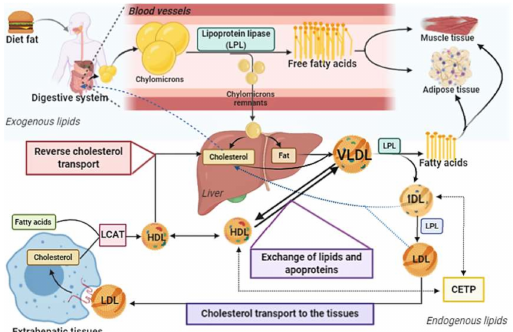
Figure 1. First, dietary fat is emulsified by bile salts, being degraded by lipases. Fatty acids are absorbed through the intestinal mucosa, being converted into triacylglycerol. Then there is the joint incorporation of cholesterol, triglycerides and apolipoproteins (Apo-CII and Apo-B48), forming the chylomicrons. Dietary fat is transported in the blood and lymph vessels by the chylomicrons. Apo-CII on the surface of chylomicron activates the enzyme lipoprotein lipase (LPL), which releases fatty acids and glycerol to tissues, mainly muscle and adipose tissues. In tissues, fatty acids can be esterified and stored or used to generate energy in cellular function. This process results in the formation of chylomicron remnants (Apo-B48 and Apo-E in surface), that have cholesterol and low triglyceride content. They are transported to the liver, where receptors bind to the Apo-E, leading to endocytosis and subsequent degradation in lysosomes, with the release of cholesterol and fatty acids. In the liver, very-low density lipoprotein (VLDL) is formed. It is rich in triacylglycerols (about 55%) and contains on its surface the following Apos: B100, E and C I, II, III. The Apo-C and -E in VLDL come from plasma high-density lipoproteins (HDL). In addition, during the lipolysis process, Apo-C, cholesterol and phospholipids are transferred from VLDL to HDL. LPL hydrolyzes VLDL in capillaries releasing fatty acids to tissues. The hydrolysis process gives rise to the IDL (or remaining VLDL), with Apo-E and Apo-B100 on its surface. IDLs are endocytosed in the liver, after binding to the low-density lipoprotein (LDL) (Apo-B100) or LDL receptor related protein (LRP) (binding to the Apo-E). IDL is also converted to LDL (about 50% cholesterol) by the action of liver LPL, which contains only one Apo-B100 molecule on its surface. This mechanism is not yet fully described. However, it is believed that there is an exchange of apolipoproteins and lipid content between HDL and IDL, by cholesterol ester transfer protein (CETP), together with phospholipid and triacylglycerol hydrolysis by hepatic LPL for the formation of LDL. LDL transports cholesterol to the extra-hepatic tissues by the binding of Apo-B100 to the LDL receptor or scavenger receptors followed by endocytosis. LDL receptor expression is downregulated by the content of intracellular cholesterol. Cholesterol is transported from tissues to the liver by HDL, which contains apolipoproteins A, C and E. In tissues, the ATP-binding cassette (ABC)-A1 and G1 proteins participate of the transport of cholesterol to HDL. Cholesterol in plasma is esterified by lecithin-cholesterol acyl transferase (LCAT), an enzyme activated by apolipoprotein-AI (Apo-AI). LCAT, in conjunction with lecithin (present in HDL), catalyzes the formation of cholesterol esters from fatty acids. As HDL captures cholesterol from tissues or lipoprotein hydrolysis, its diameter increases, from nascent HDL to discoid HDL. When the cholesterol ester content is taken, HDL migrates to the liver, binds to the Apo-AI receptor, and is released in hepatocytes. Then, cholesterol can originate VLDL or be excreted via the biliary or fecal